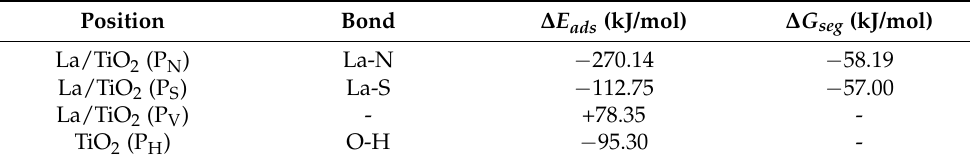
Table 2. Adsorption energy and heat segregation for different